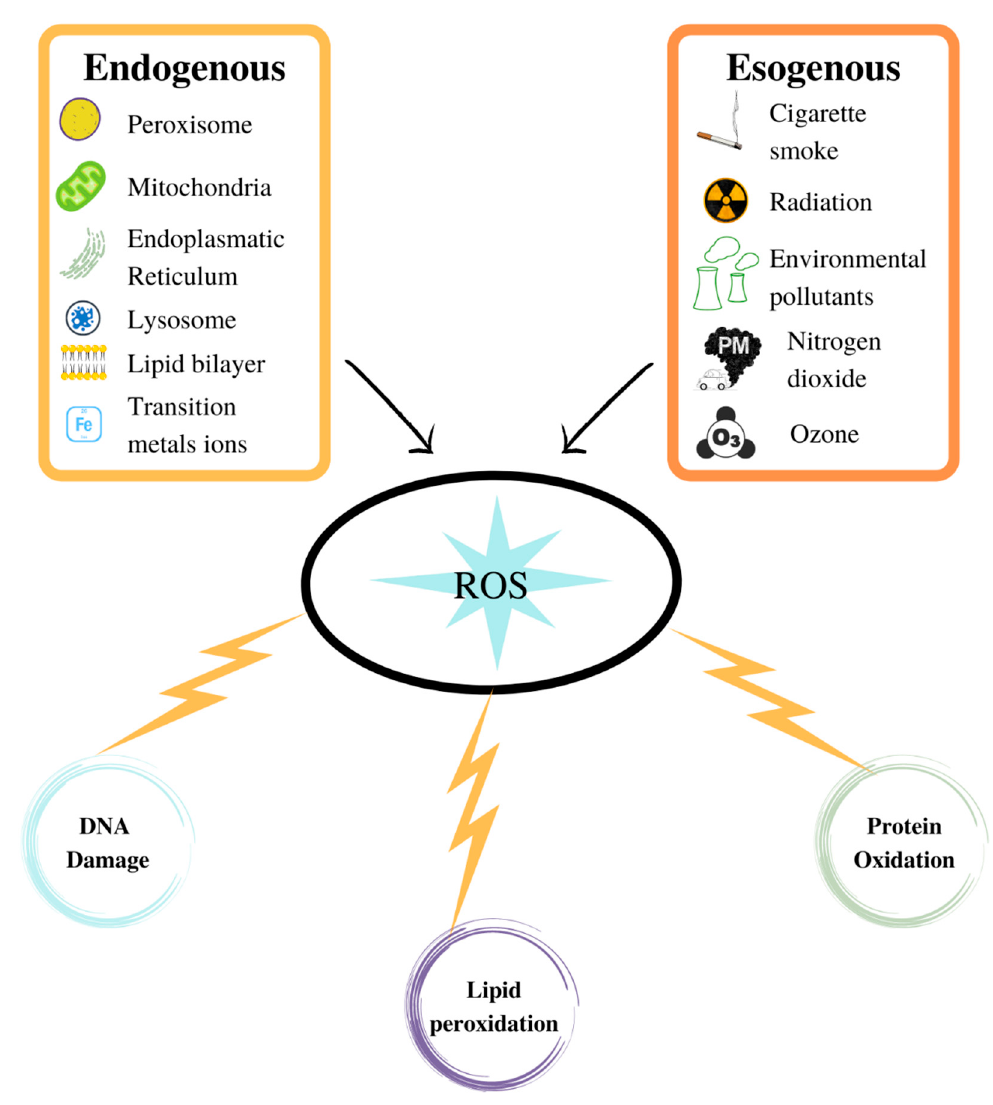
Figure 2. ROS production in aerobic organisms can be better verified via an exogenous source than through normal physiological processes. ROS can damage the biological macromolecules.